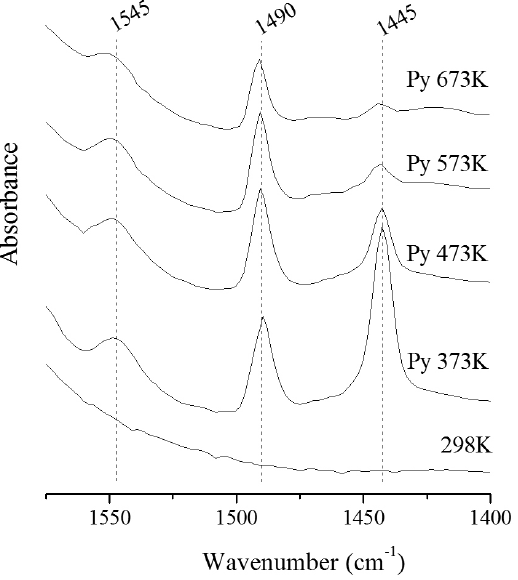
Figure 3. FT-IR spectra of pyridine adsorbed on the sample La Al 2 11